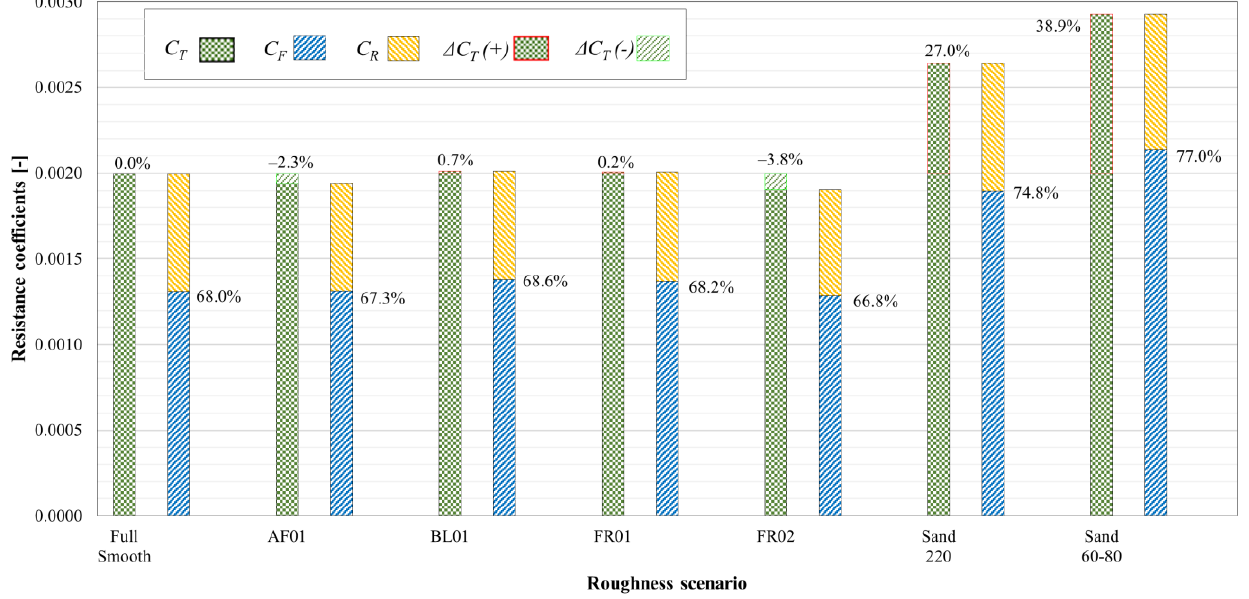
Figure 14. Percentage bar diagram of the resistance coefficients in different hull roughness conditions.